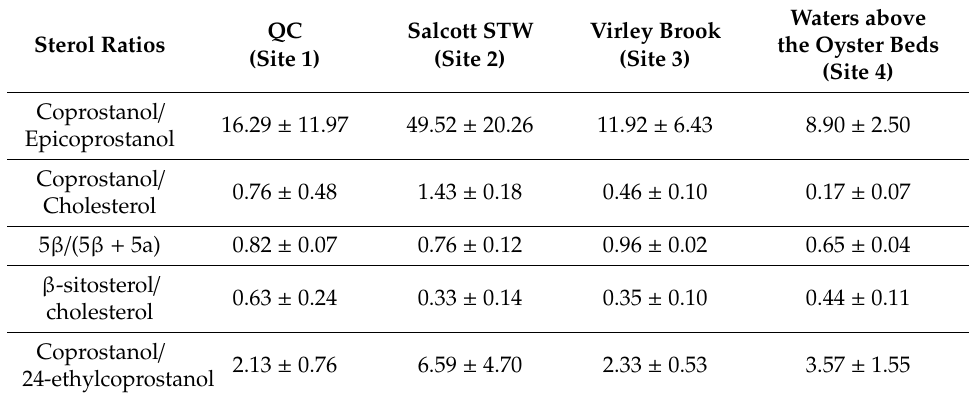
Table 7. Values of five sterol ratios for samples constituting the major inputs of faecal pollution in Salcott Creek (mean ± standard